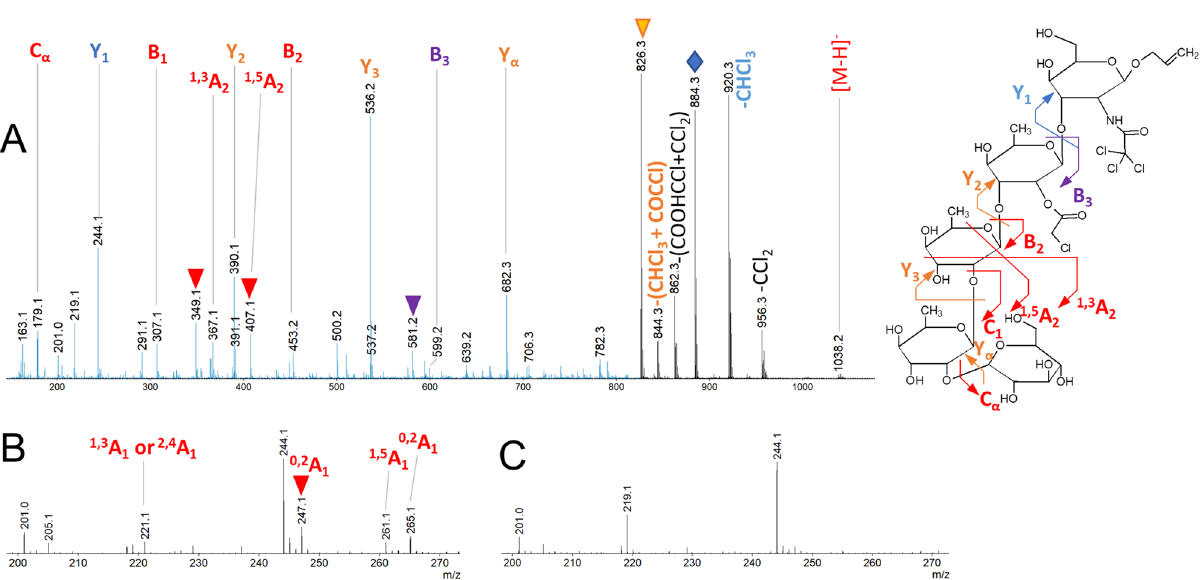
Figure 7. ( A ) UHPLC-ESI–MS/MS spectrum of the pentasacharide isolated as [M-H] − at m/z 1038.21 at t R = 22.07 min in samples M35 validated as being glucosylated on OH-2 A . ( B ) Zoom in the mass range m/z 200– 270 of the P2 product (glucosylation on OH-3 A ). ( C ) Zoom in the mass range m/z 200–270 of the P2 ″ product (glucosylation on OH-2 A ). The blue area of the spectrum is enlarged by a factor of 2 in the intensity axis. Annotations in red correspond to intact product ions. Annotation in blue correspond to product ions with a loss of CHCl 3 . Annotations in purple correspond to product ions with a loss of COCHCl. Annotation in orange correspond to product ions with a loss of CHCl 3 + COHCl 3 . All these labile function losses are in agreement with the structure. Red * indicate consecutive fragmentations, ▽ indicate H 2 O loss, ◊ indicate HCl loss. For clarity, only one fragment per pair (B, C and Y, Z) was reported on the annotated